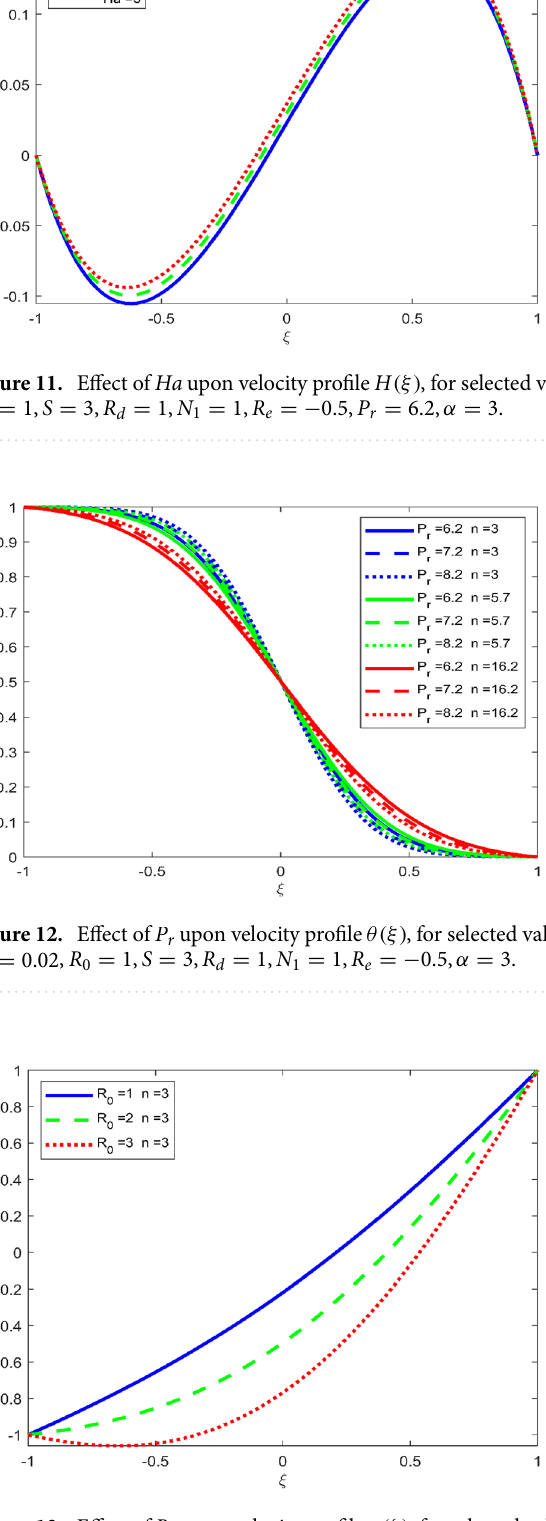
Figure 13. Effect of R 0 upon velocity profile g (ξ) , for selected values of β = 0.2, m = 1, Ha = 1, φ 1 = φ 2